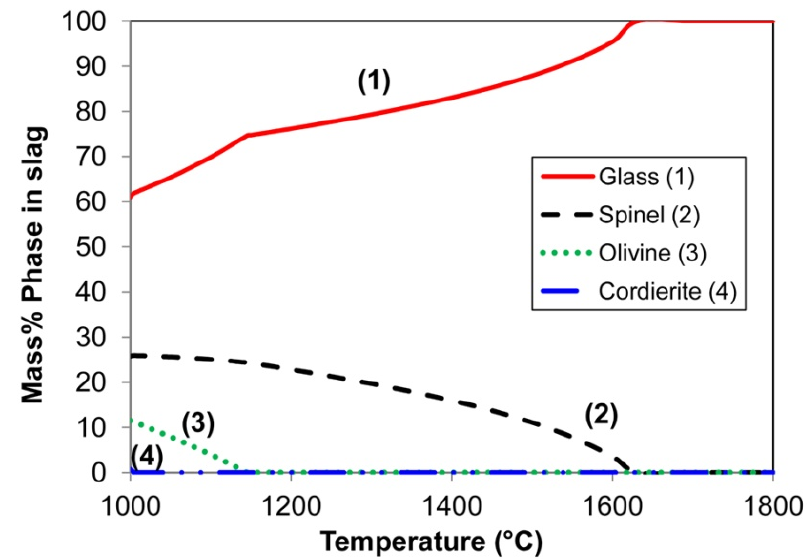
Figure 10. Solidification curve for the adjusted flux chemistry composition (30% CaF 2 –23% SiO 2 –23% Al 2 O 3 –23% MgO), as calculated in FactSage 7.3 [40,41].